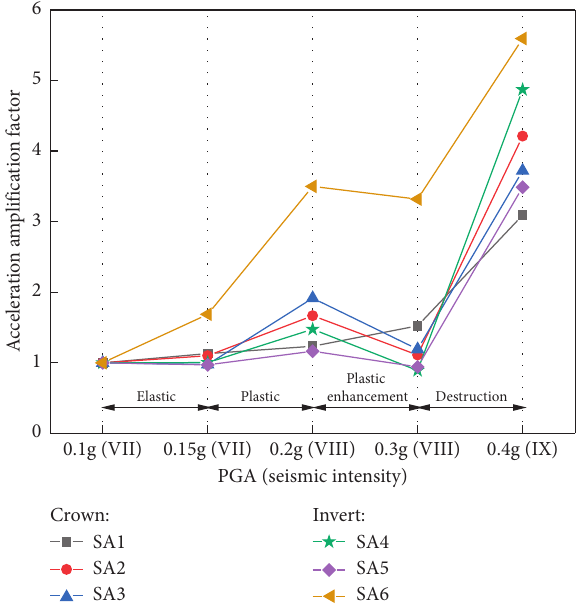
Figure 10: Acceleration amplification factor of the upper-span